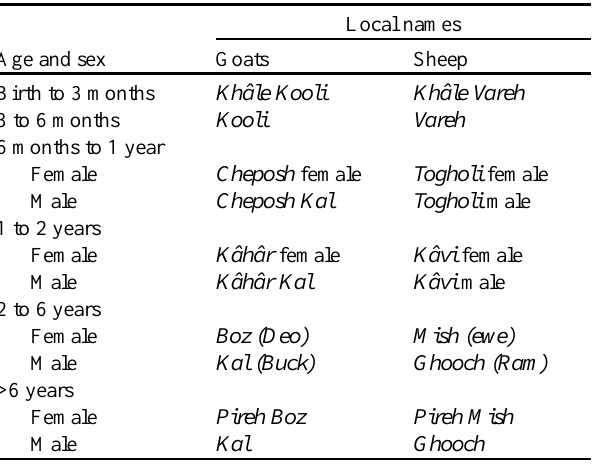
Table 1 . Local names for sheep and goats in Nariyan village, by age and